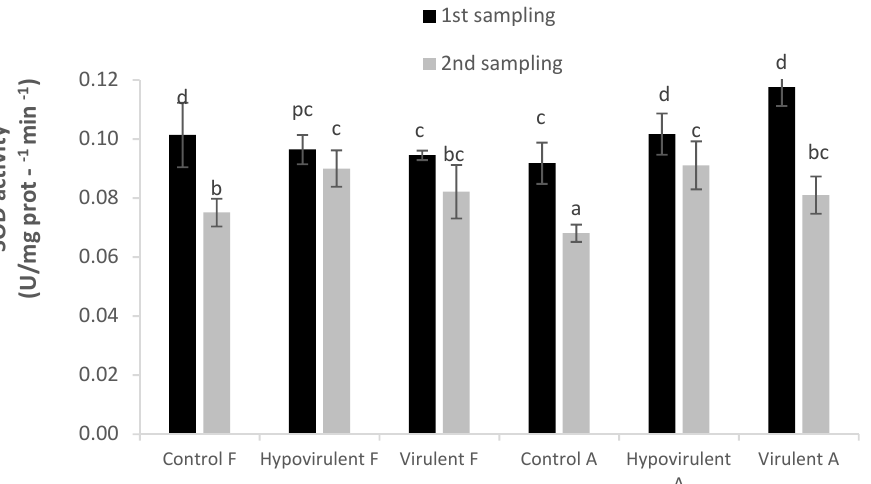
Figure 3. The effect of Cryphonectria parasitica hypovirulent and virulent strains on SOD activity of Castanea sativa, 21 and 42 days after infection . Values are means ± SD, n=5. Significant differences among samples based on the Tukey-HSD test. F: leaf above the infection, A: leaf under the infection. The results of lipid peroxidation measurements at the time of the first sampling were also statistically higher in the leaves above hypovirulent (Hypovirulent-F) and virulent (Virulent-F) necrosis than in the control leaves. The amount of malondialdehyde (MDA) measured in leaves under artificial infection (Hypovirulent-A, Virulent-A) was similar to that in control leaves (Control-A). These differences changed somewhat during the second sampling, however, the values of the leaves above the infections (Hypovirulent-F, Virulent-F) were also statistically different from the others but were similar to each other (Figure 4).